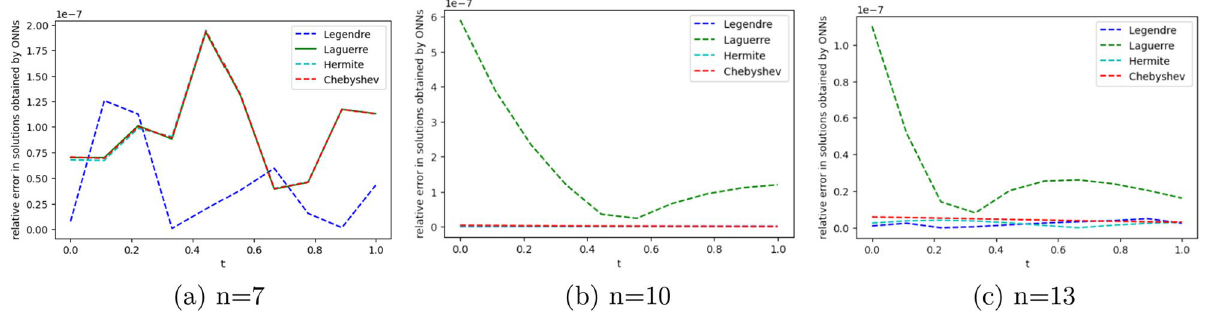
Figure 21. Error graph of z 3 ( t ) for different orthogonal neural networks with different numbers of neurons for Example